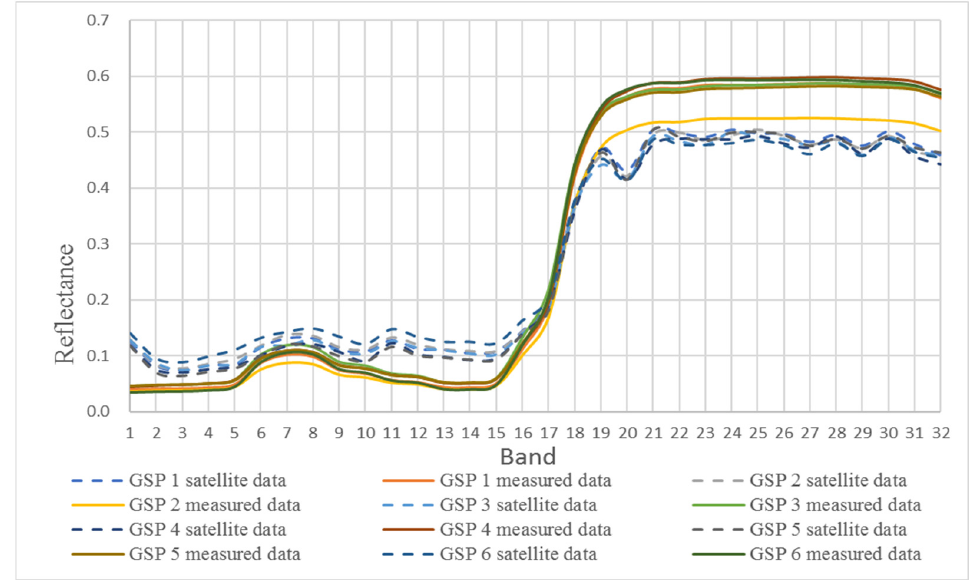
Figure 16. The satellite reflectance retrieved from OHS-F CMOS2 image and corresponding ground synchronous surface reflectance.